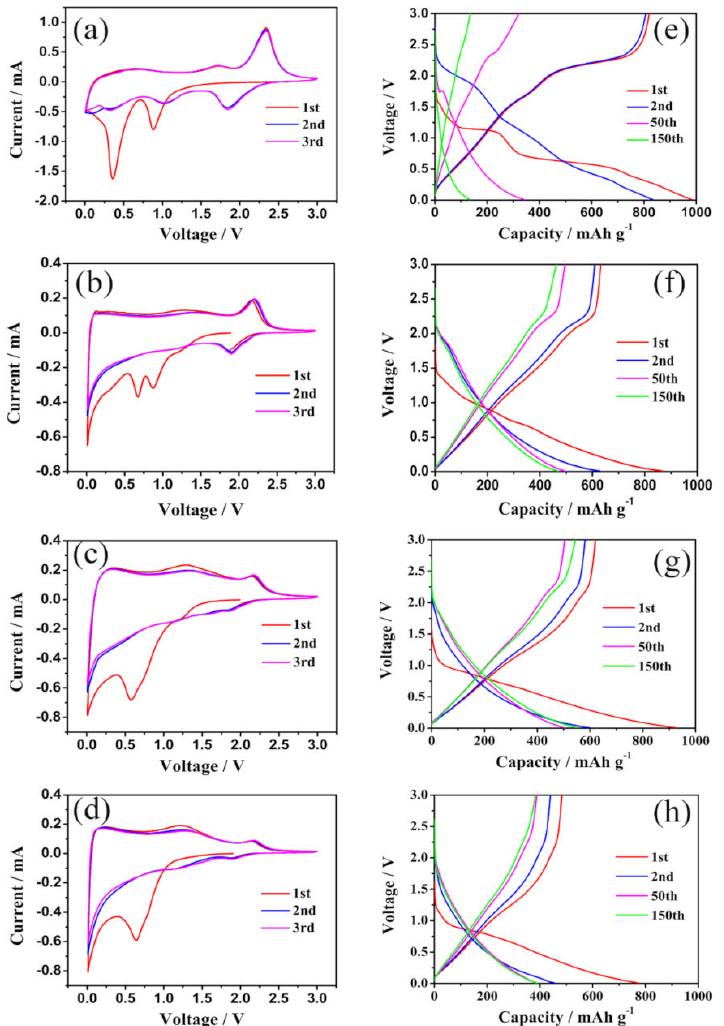
Figure 6. Cyclic voltammograms (CV) of ( a ) pristine MoS 2 , ( b ) MoS 2 /C-1, (c) MoS 2 /C-2, and ( d ) MoS 2 /C-3 composite electrodes; galvanostatic charge/discharge profiles of ( e ) pristine MoS 2 , ( f ) MoS 2 /C-1, ( g ) MoS 2 /C-2, and ( h ) MoS 2 /C-3